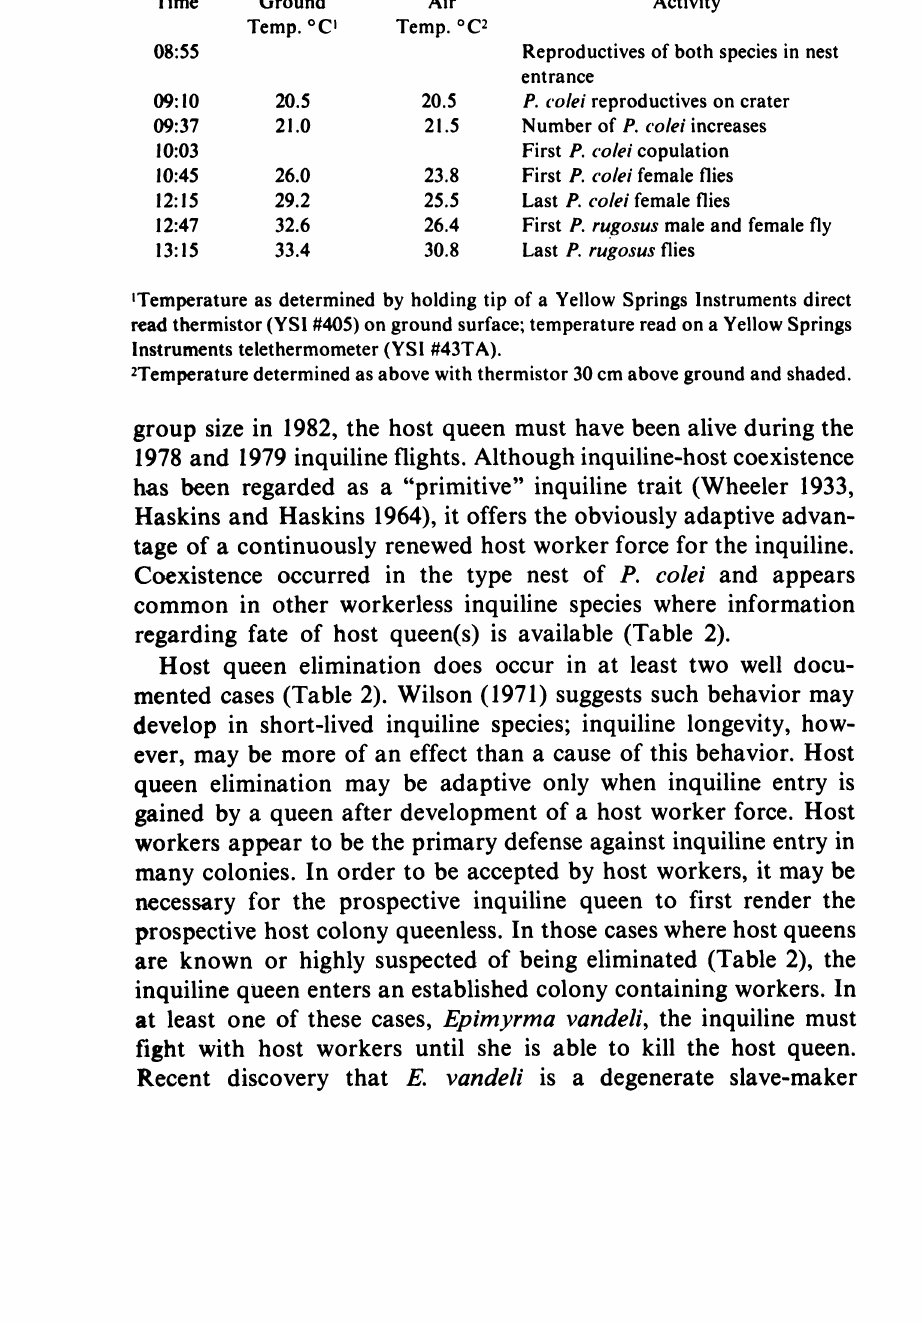
Table I. Summary of mating activities of P. colei and P. rugosus in Boulder City, Nevada, 15 September